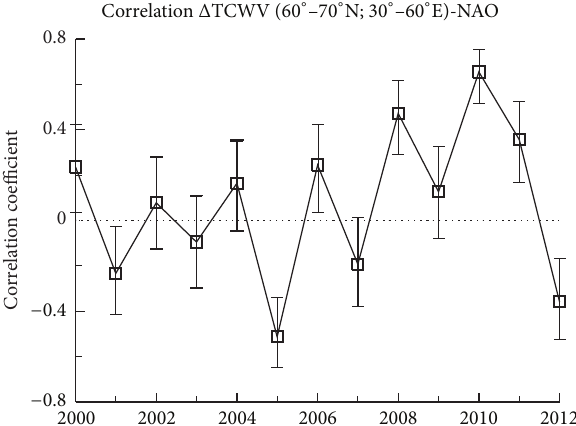
Figure 4: Correlation coefficients between the daily TCWV anoma- lies averaged over the territory restricted by the coordinates 60 ∘ – 70 ∘ N; 30 ∘ –60 ∘ E and the daily normalized NAO index in June– August calculated for each year in the period 2000–2012. Vertical bars denote ± 95% confidence